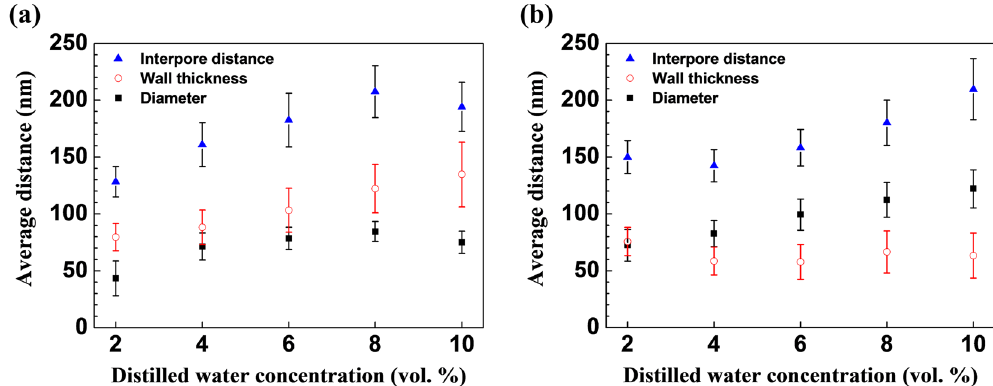
Figure 4. Average interpore distance, wall thickness, and diameter of TiO 2 nanotube arrays anodized at 60 V for 1 hour in ethylene glycol containing (a) 0.2 wt% NH 4 F and (b) 0.4 wt% NH 4 F as a function of vol% of distilled